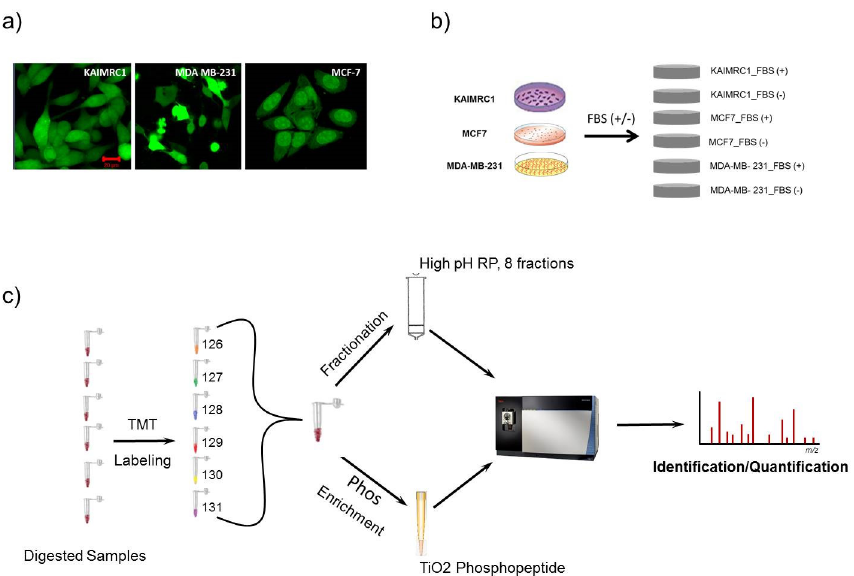
Figure 1. Schematic description of the experimental design employed in proteomics analysis: ( a ) KAIMRC1, MCF-7, and MDA-MB-231 cells stained for cytoplasm (Green) with Cytotracker® Green. ( b ) Three cell lines, KAIMRC1, MCF-7, and MDA-MB-231, were stimulated with or without Fetal Bovine Serum (FBS); ( c ) quantitative proteomics analysis workflow using a tandem mass tag (TMT) strategy with High pH Reversed-Phase Peptide Fractionation technique and TiO2 phosphopeptide enrichment methods. Table 1. Summary of the number of identified proteins and phosphoproteins in each cell line. Cell Lines